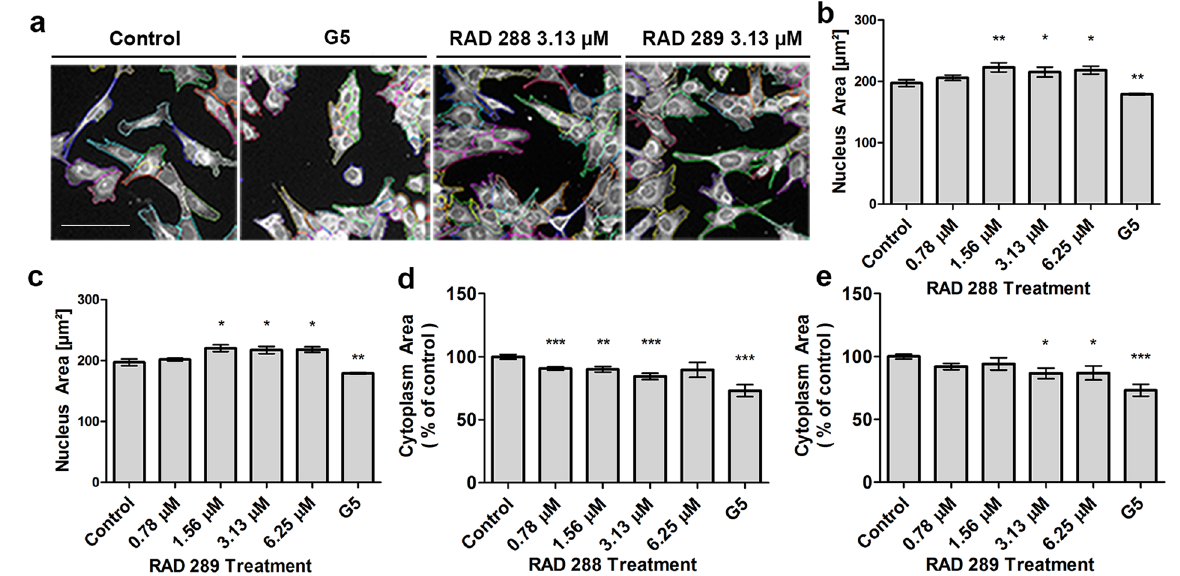
Figure 4. Effect of RAD288 and RAD289 on morphology of mOECs. ( a ) Representative images of mOECs after drug exposure. Images were segmented with Harmony software using Find Cytoplasm method. Scale bar = 100 µ m. ( b ) Nucleus area of mOECs after treatment with several concentrations of RAD288. ( c ) Nucleus area of mOECs after treatment with a range of concentrations of RAD289. ( d ) Cytoplasm area of mOECs after treatment with several concentrations of RAD288. ( e ) Cytoplasm area of mOECs after treatment with a range of concentrations of RAD289. Negative control (0.2% DMSO) and positive control (1% G5 Supplement) were used. Triplicate wells were used in three separate experiments. Results represent the mean + / − SEM.